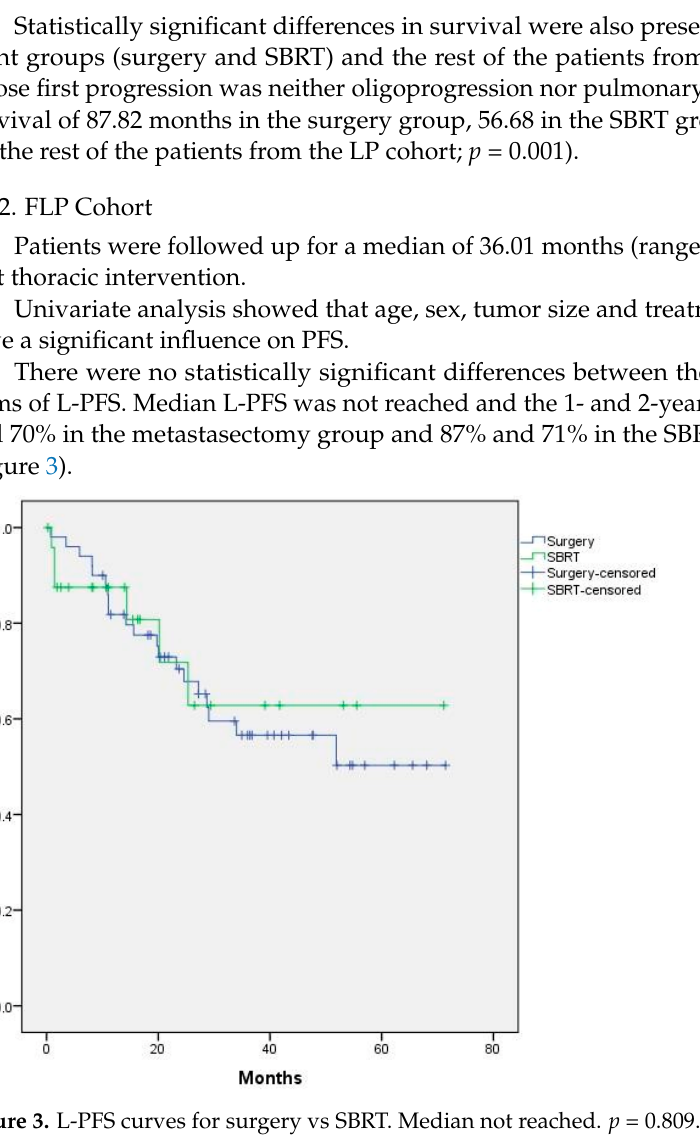
Figure 2. Overall survival depending on the type of first progression (multiple versus oligo) in the initial cohort of 100 patients (OS-LP). p < 0.001.